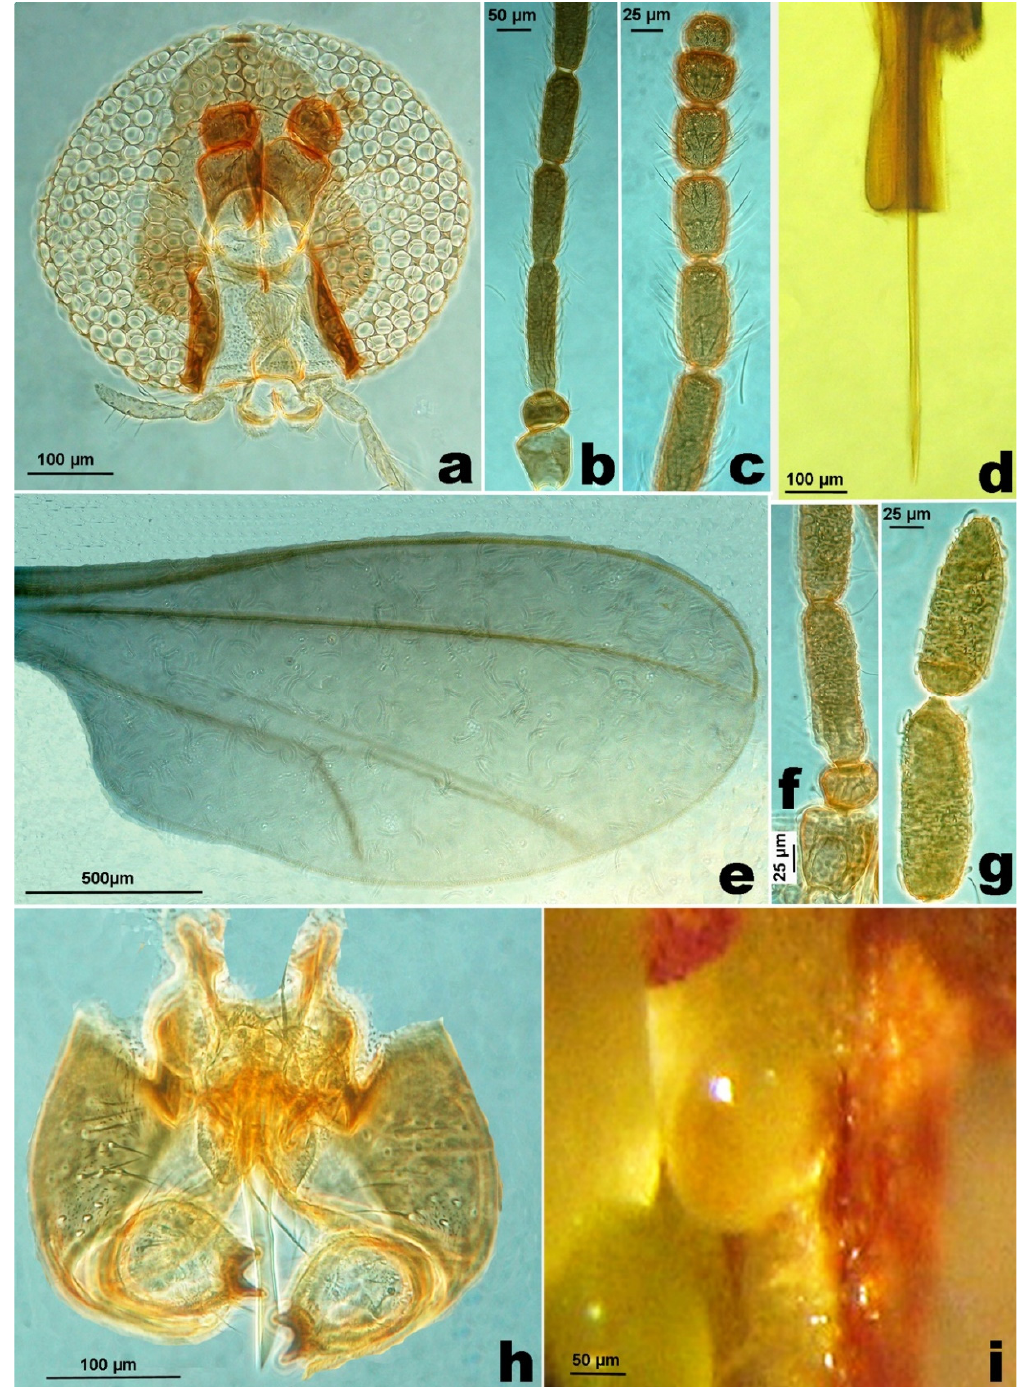
Figure 5. Asphondylia micromeriae . ( a ). Female, head, frontal view. ( b ). Basal segments of female antenna. ( c ). Distal segments of female antenna. ( d ). Ovipositor. ( e ). Fore wing. ( f ). Basal segments of male antenna. ( g ). Distal segments of male antenna. ( h ). Genitalia. ( i ). Laid Asphondylia egg.